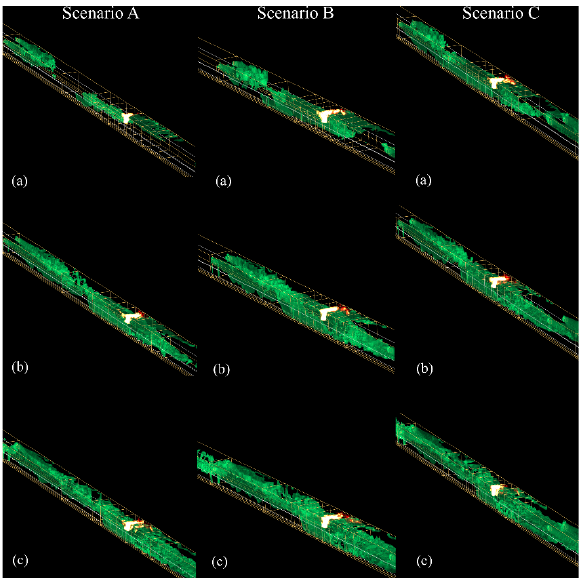
Figure 11. Development of the critical ventilation velocity of 2.7 m/s (isosurface with the green colour), at the train location, for ( a ) +90 s, ( b ) +180 s, and ( c ) +300 s after the activation of the jet fans. The jet fans reached their maximum output 90 s after their activation, while the development of the flow was reached approximately after 300 s.